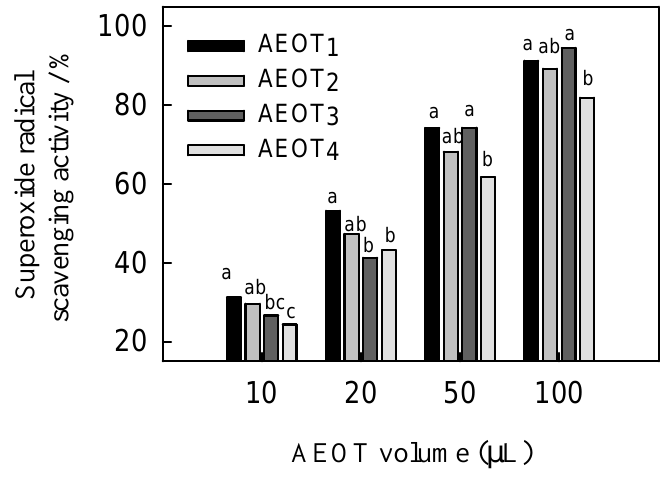
Figure 2. Effects of AEOT under different steeping conditions at various concentrations of oolong tea aqueous infusion on the superoxide radical scavenging activity. Different letters indicate significant differences between treatments according to Tukey multiple comparisons ( p <0.05).